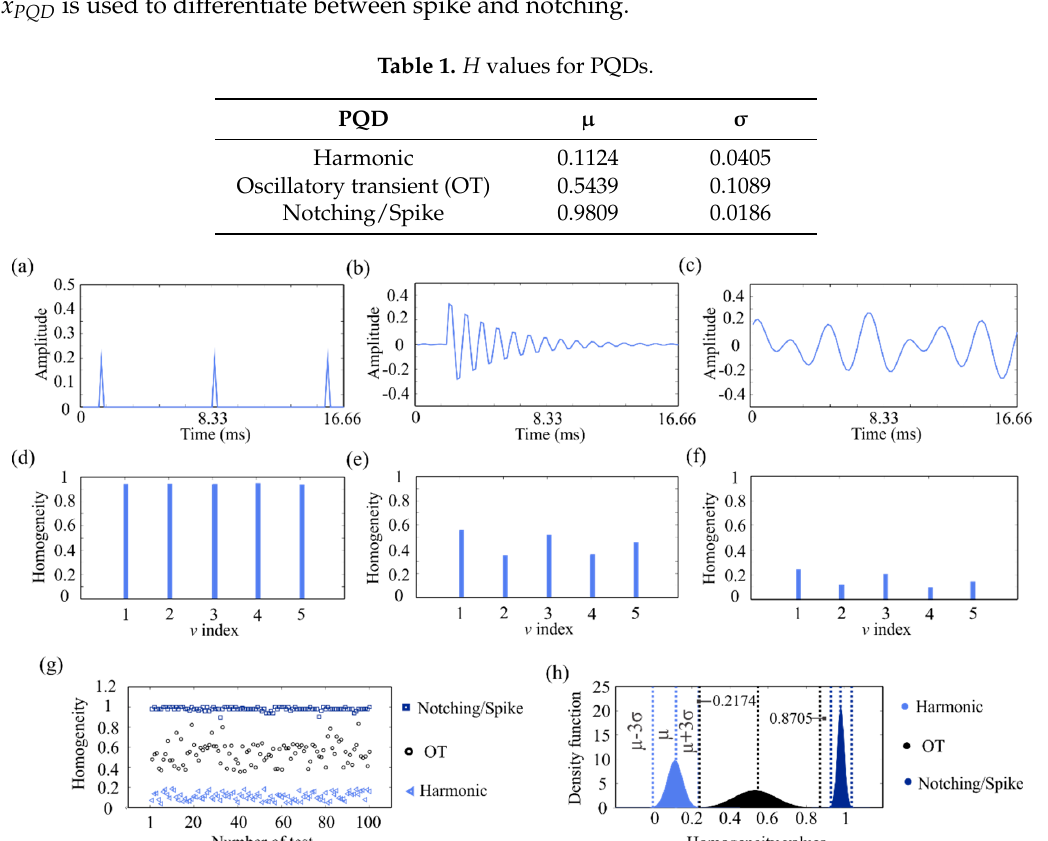
Figure 4. Homogeneity results: ( a ) notching/spikes, ( b ) oscillatory transient, ( c ) harmonics, ( d ) homogeneity index ( H ) for notch/spike, ( e ) H for oscillatory transient (OT), ( f ) H for harmonics, ( g ) H values for PQDs, and ( h ) probability density functions.